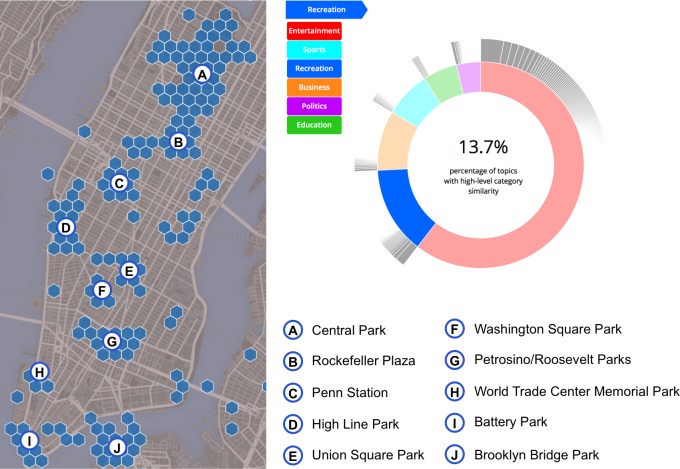
Spatially significant high value recreation clusters over NYC.The hexagon map depicts the statistically significant spatial clusters by point count coloured in blue. The results show a significant spatial alignment with prominent parks in NYC. The pie chart (right) shows that 13.7% of the total topics discovered from the entire NYC Twitter resulted in the highest semantic similarity with recreation out of the other five categories. Large clusters are annotated with location names to show spatial alignment.